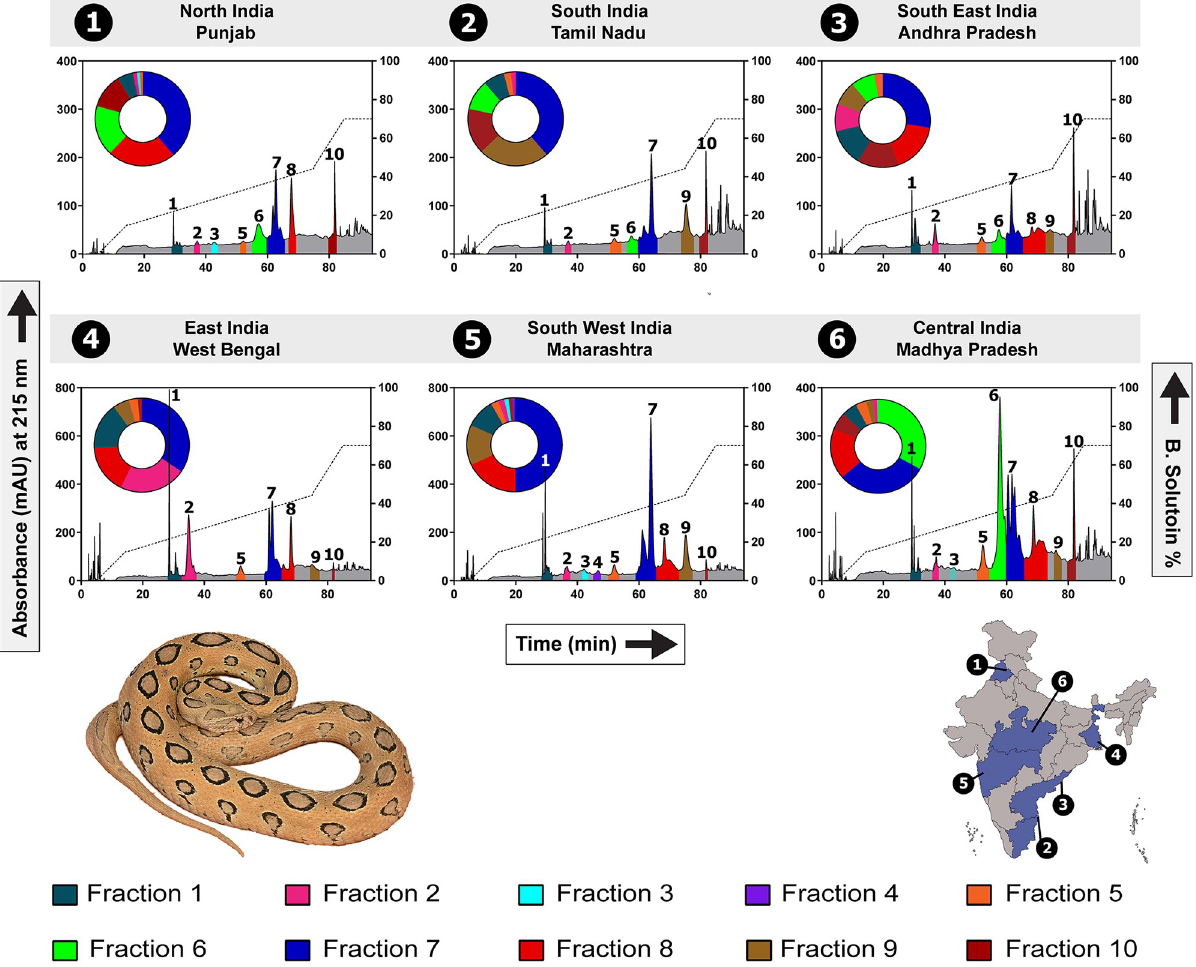
Fig 2. Venom variability in pan-Indian D . russelii populations. This figure depicts RP-HPLC profiles of D . russelii venoms sourced from distinct biogeographic zones. Venom profiles, shown here, highlight the considerable differences in the protein compositions of geographically distinct populations. The area under the curve for all labelled and uniquely colour coded fraction peaks are depicted in the corresponding doughnut charts.